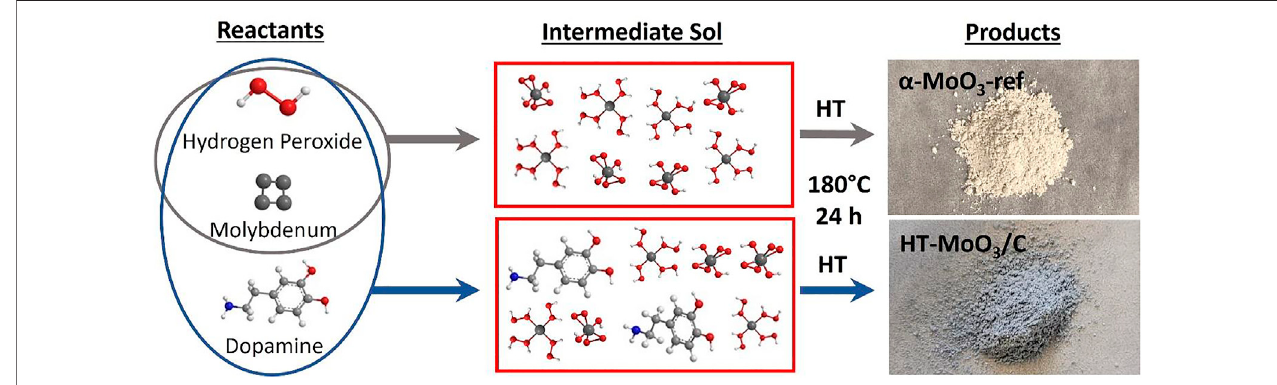
FIGURE 1 | Schematic illustration of the synthesis process involving sol-gel reaction between metallic molybdenum and hydrogen peroxide with and without the presence of dopamine hydrochloride. The product of the sol-gel reaction was hydrothermally treated (HT) to produce white α -MoO 3 -ref and light-blue HT-MoO 3 /C